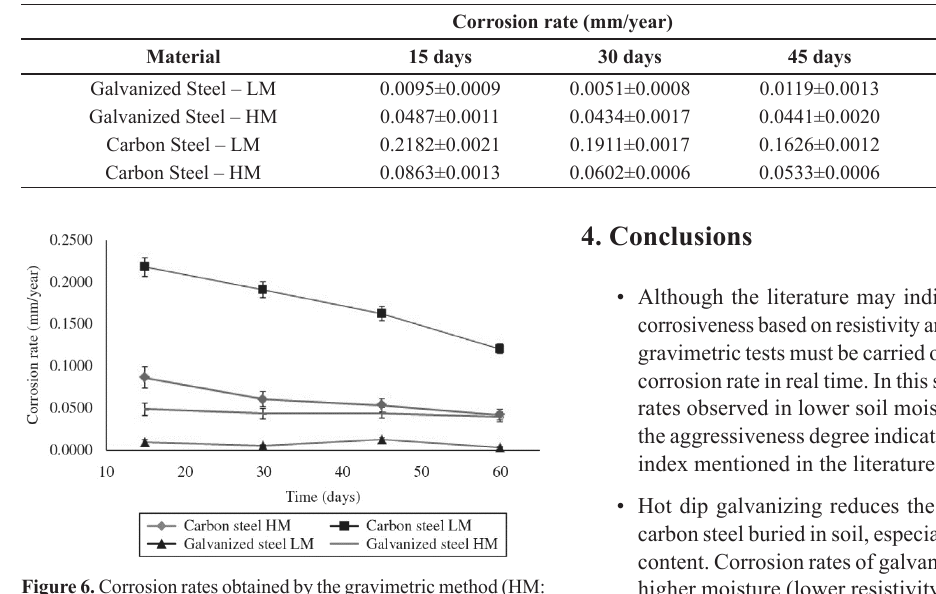
Table 3. Corrosion rates obtained by the gravimetric method to galvanized steel and carbon steel. (HM: High moisture e LM: Low moisture).